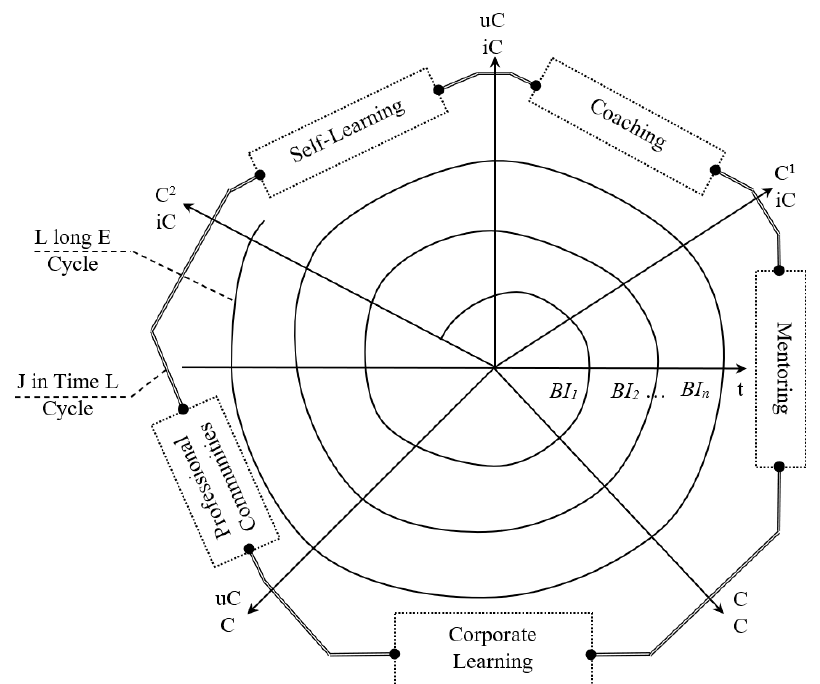
Figure 1. M odel for the development of creative entrepreneurial competences